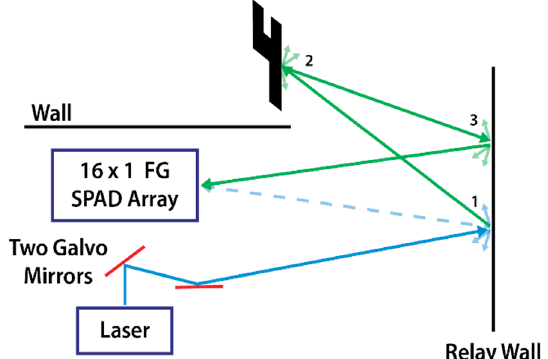
Figure 11. Photon paths through the scene of the NLOS experimental setup. Two galvo mirrors are used to project the laser beam on the relay wall, from which photons are scattered through the scene (first bounce). While ballistic photons reaching the 16 × 1 fast-gated SPAD detector are time-filtered, some of the remaining photons will reach the hidden object and will be reflected back to the relay wall and, finally, to the detector.